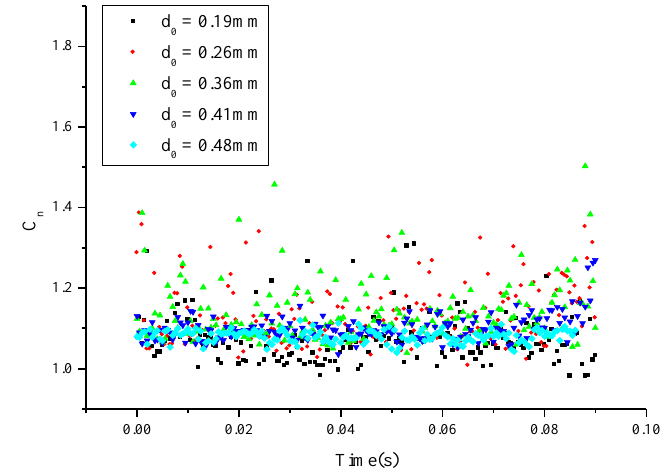
Figure 12. Scatter distribution for C n with time for droplets of different diameters.